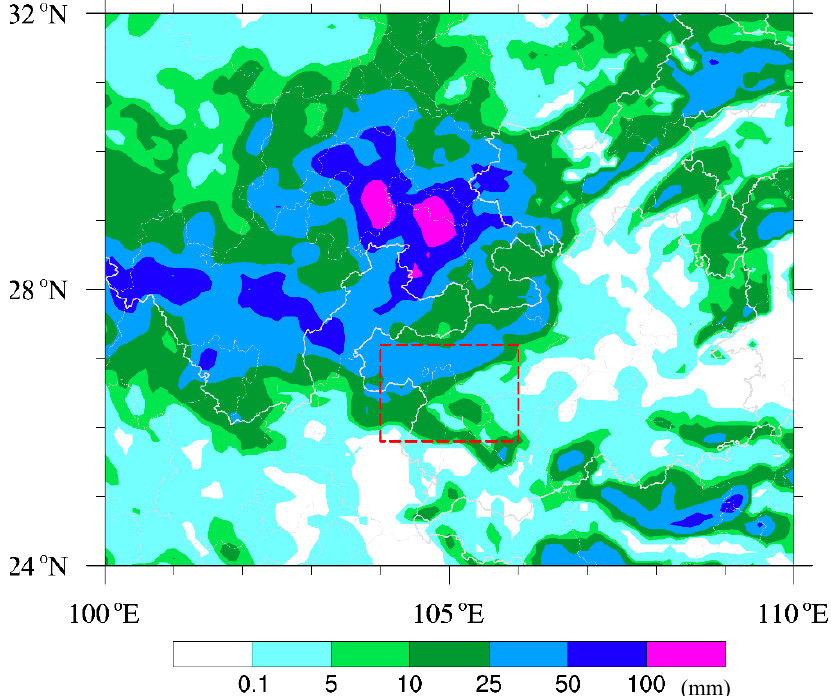
Figure A2. The high-resolution (0.1° × 0.1° horizontal) mesoscale model of Global/Regional Assimilation and Prediction Enhanced System (GRAPES_MESO) in China for the 24-h accumulated precipitation on 22 July 2019 (unit: mm). The lead time is 00:00 UTC on 22 July 2019. The GRAPES has two forecast systems, i.e., GRAPES_GFS (global forecast system) and GRAPES_MESO (regional forecast system). The GRAPES_MESO has assimilated the observational data of FY-2E satellite but not Dopppler wather radar. The dashed-line red box outlines the area of interest in our study.